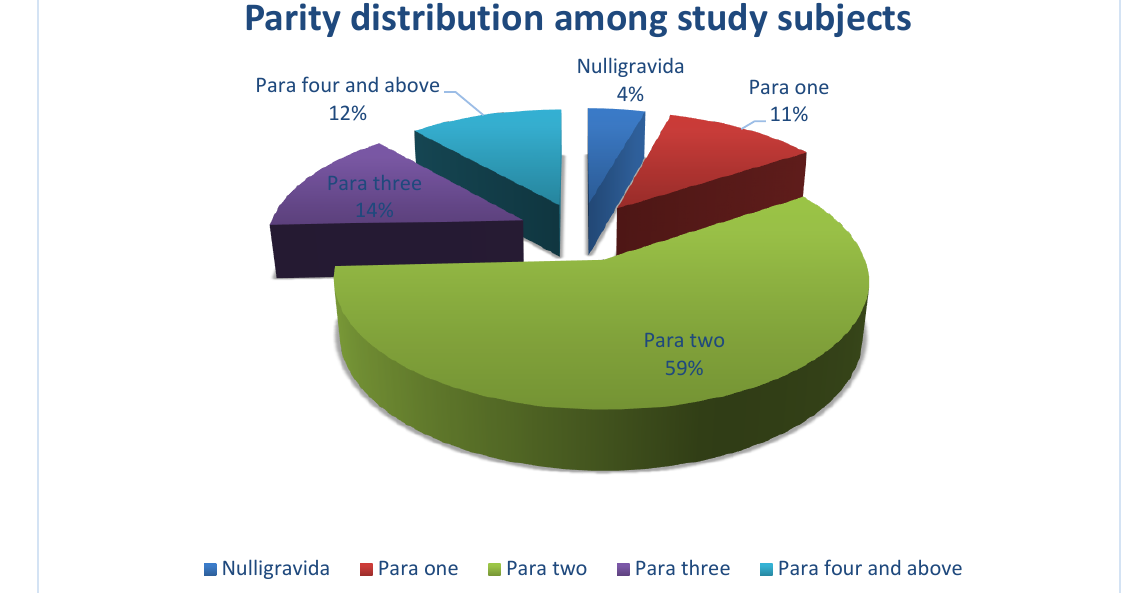
Fig. 3. The parity distribution among the study subjects.